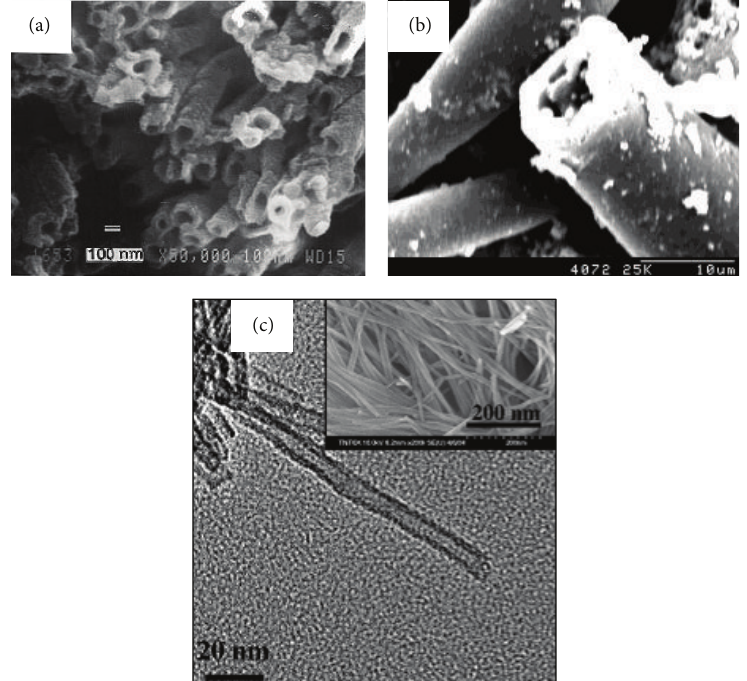
Figure 6: SEM image of TiO 2 nanotubes synthesized via an electrochemical deposition (a) [37] and templating methods (b) [42]; (c) FESEM (inset) and TEM images of TiO 2 nanotubes synthesized via a hydrothermal method [74].